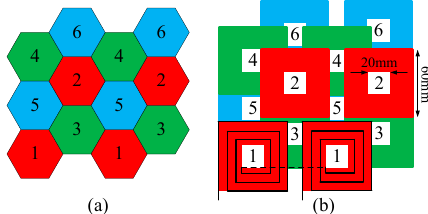
Figure 2. Detection coil layout. ( a ) Positions and arrangements of each coil, ( b ) actual coil shape and routing.